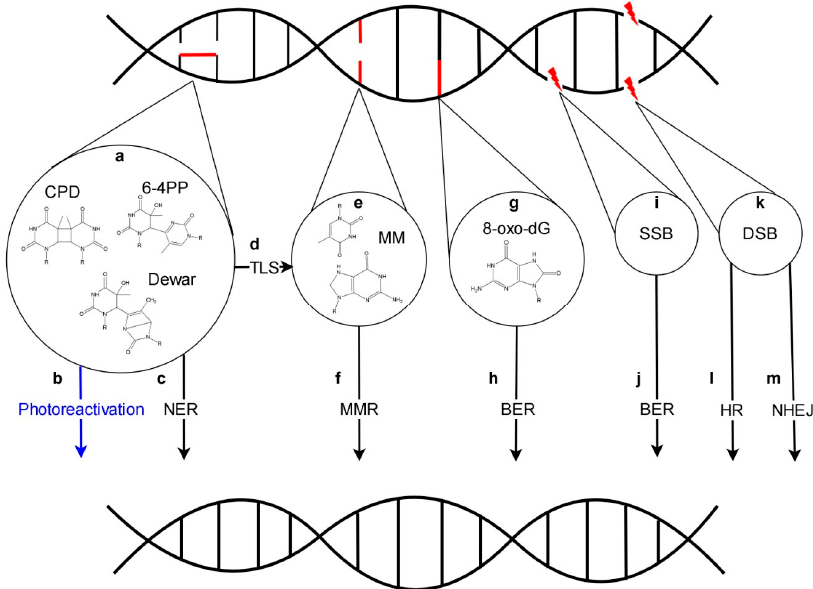
Figure 1. A scheme of DNA damage directly and indirectly caused by UV and network of mechanisms involved in their repair. UV irradiation causes formation of pyrimidine dimers ( a ) that can be repaired either by photoreactivation under UV-A / blue light ( b ) or NER (nucleotide excision repair) ( c ). Alternatively, pyrimidine dimers can be bypassed during replication by TLS (translesion synthesis) ( d ), which leads to production of mismatched bases ( e ). Mismatches are repaired by MMR (mismatch repair) ( f ). UV-induced oxidative stress may lead to formation of 8-oxo-dG ( g ) that are repaired via BER (base excision repair) ( h ). UV may also indirectly cause formation of single strand breaks ( i ) repaired by proteins involved in BER pathway ( j ) and double strand breaks ( k ), that may be repaired by HR (homologous recombination) ( l ) or NHEJ (non-homologous end joining) ( m ). Black arrows represent the mechanisms of dark repair, while photoreactivation is marked in blue.